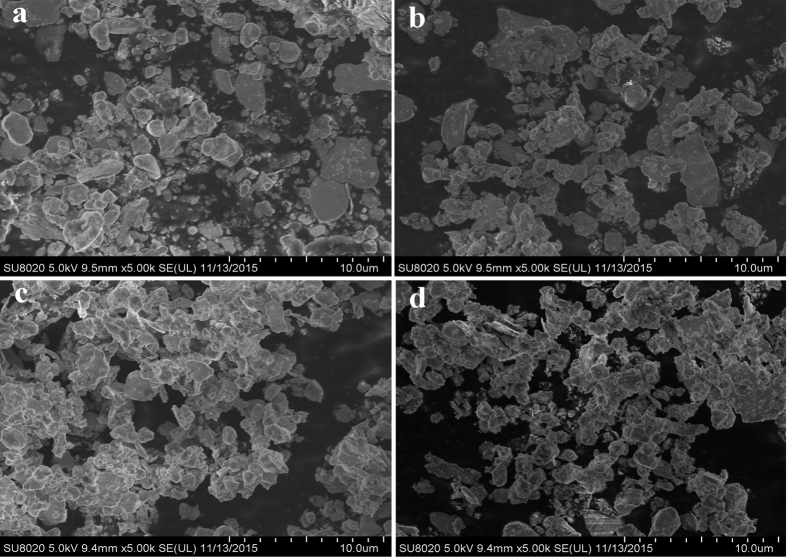
FESEM images of milled pure W and W-LuH2 composite powder.(a) pure W; (b) W-2%Lu; (c) W-5%Lu; and (d) W-10%Lu.